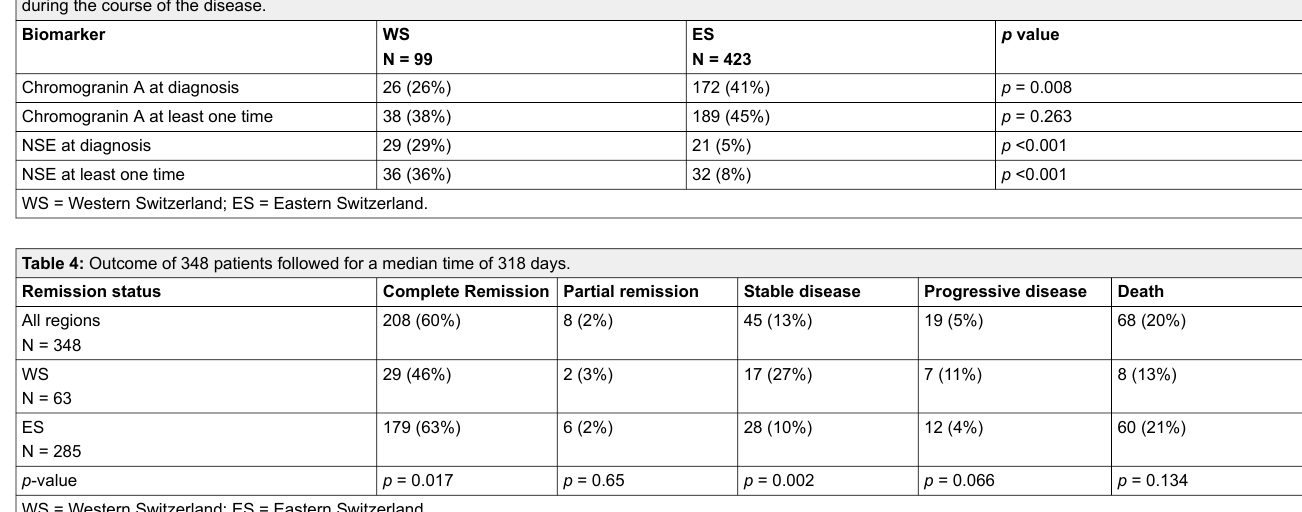
Table 3: Laboratory workup. Number of patients who had either chromogranin A or neuron-specific enolase (NSE) levels measured at diagnosis, or at least one time during the course of the disease. Biomarker